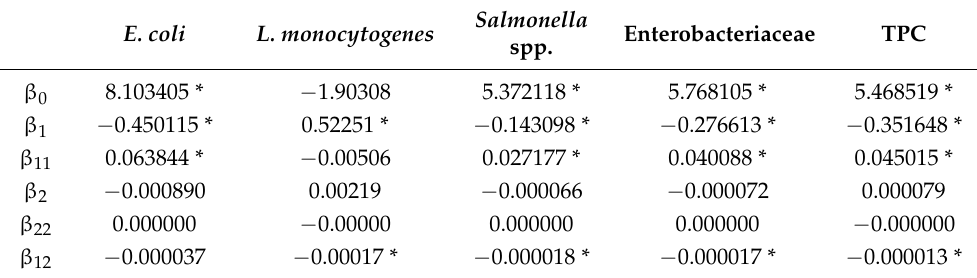
Table 3. Second-order polynomial regression coefficients for five selected microorganisms in molasses. E.